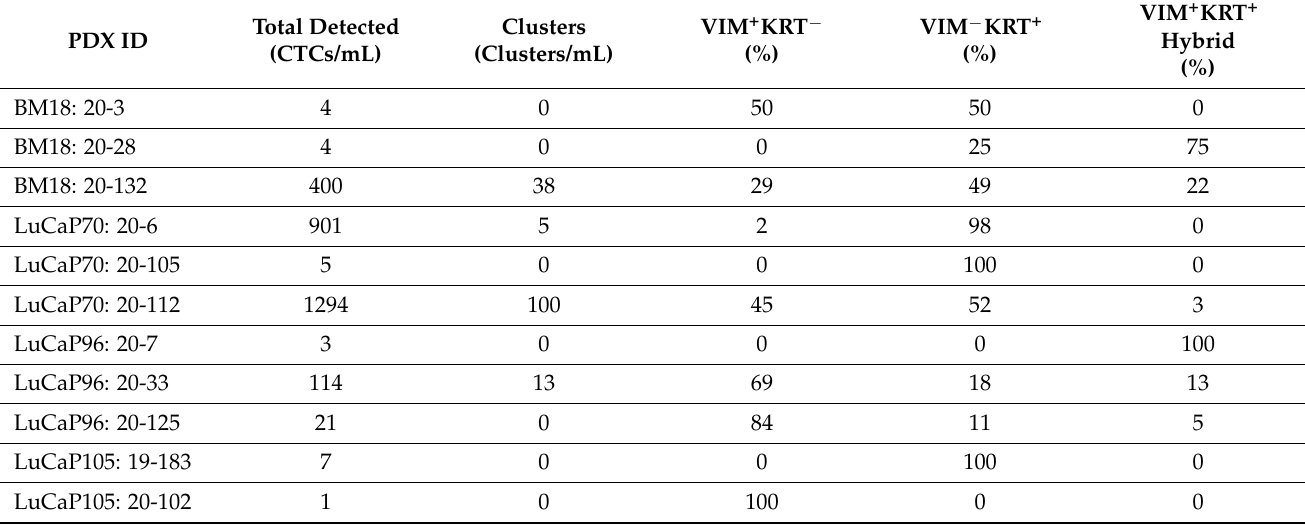
Table 1. Circulating tumour cell vimentin/keratin immunofluorescence cytology for PDX blood